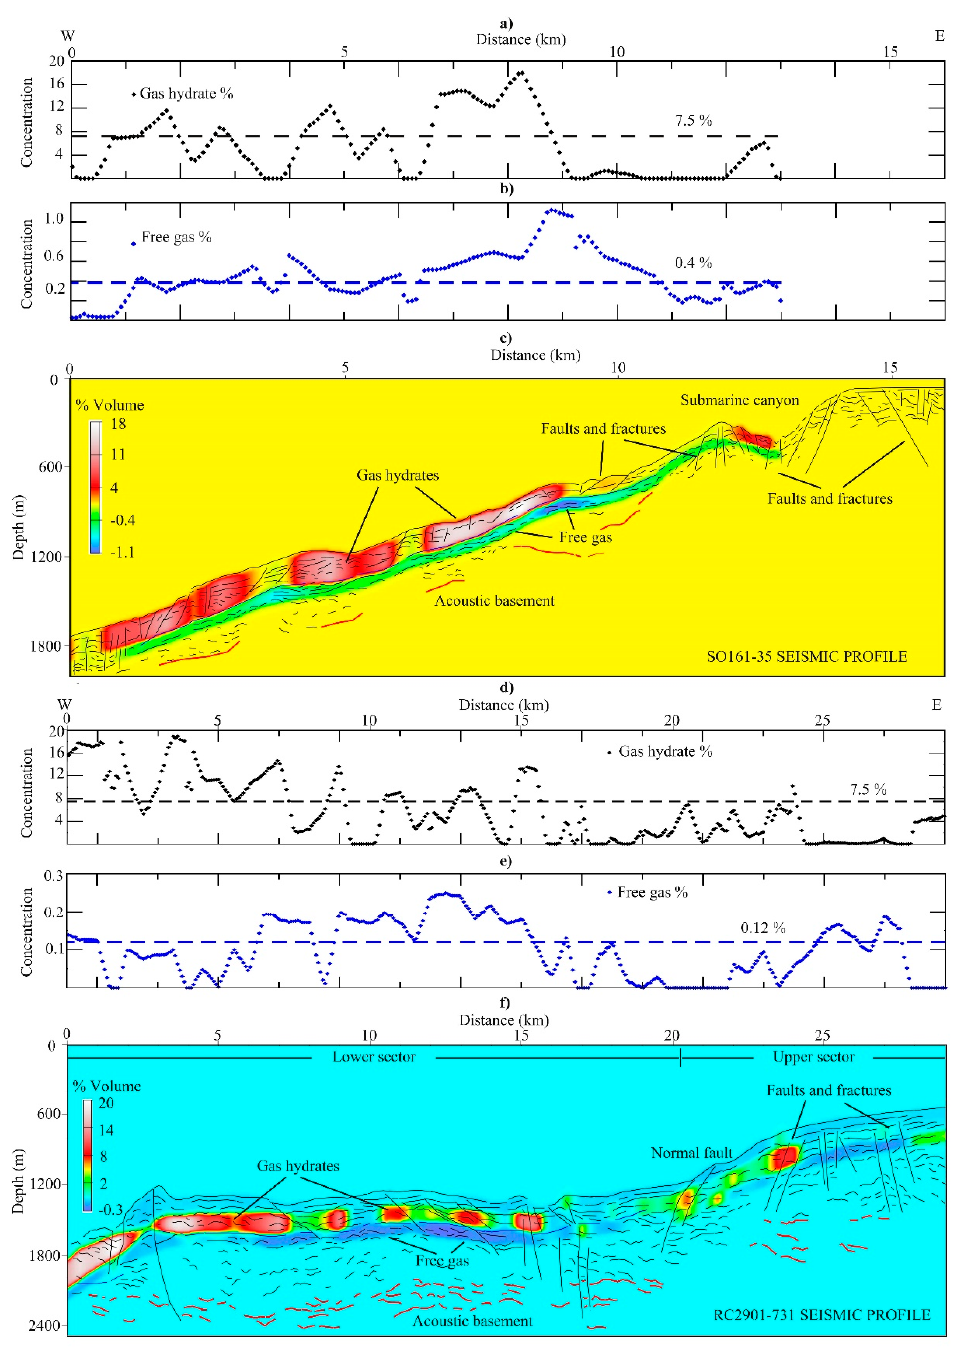
Figure 3. Line drawing sections with superimposed gas-phase (gas hydrate and free gas) concentration models. In ( a ) gas hydrate and ( b ) free gas concentration profiles for SO161-35 seismic profile, ( c ) SO161-35 gas-phase concentration model with superimposed line drawing, ( d ) gas hydrate and ( e ) free gas concentration profiles for RC2901–731 seismic profile, ( f ) RC2901-731 gas-phase concentration model with superimposed line drawing. Above all sections are reported gas hydrate (black diamonds) and free gas (blue diamonds) concentration values. Dashed black and blue lines show average values. A variable geothermal gradient across both sections was obtained and reported in Figure 4. However, a recognisable higher geothermal gradient was identified across the SO161–35 profile